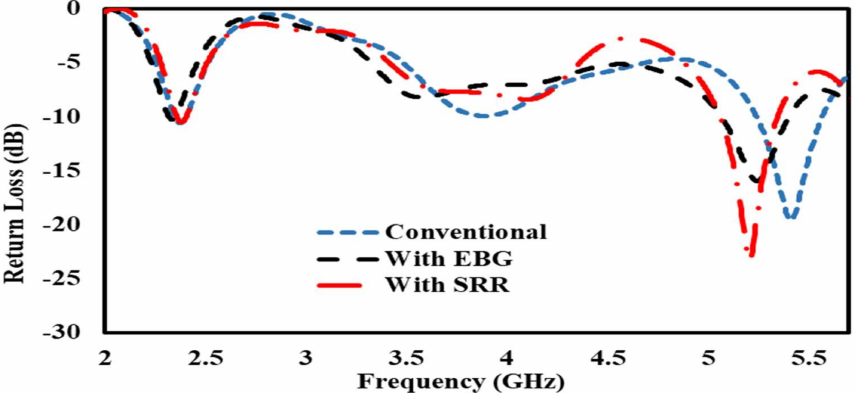
Figure 15. S11 comparison of conventional antenna, antenna on EBG, and SRR/HIS in free